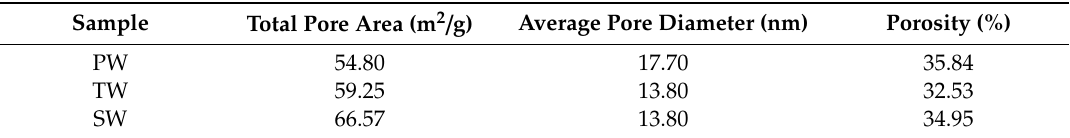
Figure 3. Mercury intrusion porosimetry (MIP) results of AAM produced with di ff erent types of water: ( a ) cumulative intrusion of mercury and ( b ) pore size distribution. Table 4. Total pore area, average pore diameter and porosity of AAM produced with di ff erent types of